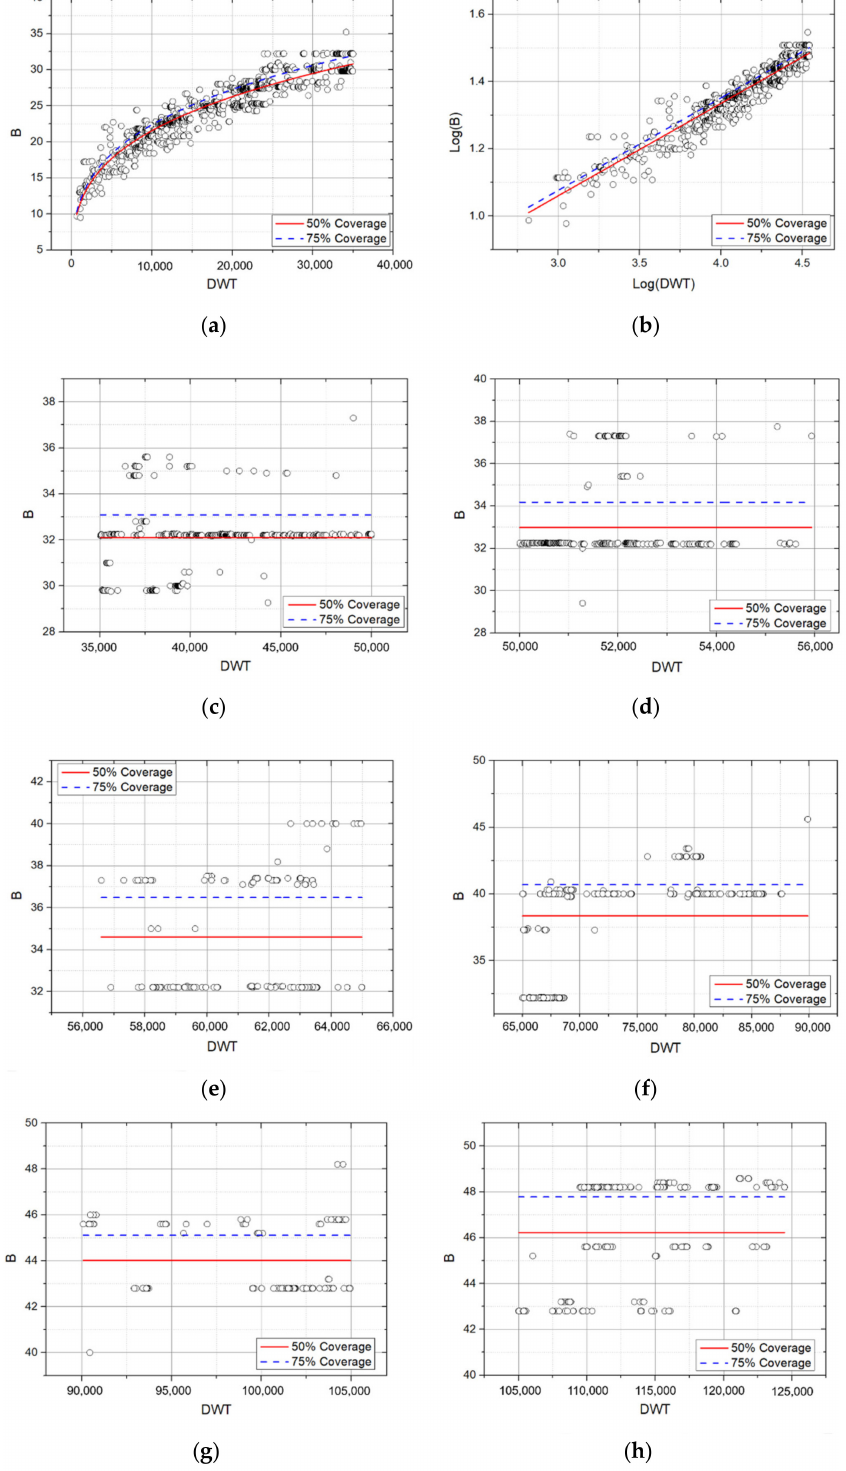
Figure 14. Results of regression analysis. ( a ) Deadweight tonnage (DWT)-breadth (B) graph of Cluster 1 (0–35,000 DWT); ( b ) Log(DWT)-Log(B) graph of Cluster 1 (0–35,000 DWT); ( c ) DWT-B graph of Cluster 1 (35,000–50,000 DWT); ( d ) DWT-B graph of Cluster 1 (50,000–55,000 DWT); ( e ) DWT-B graph of Cluster 2 (55,000–65,000 DWT); ( f ) DWT-B graph of Cluster 1 (65,000–90,000 DWT); ( g ) DWT-B graph of Cluster 2 (90,000–105,000 DWT); ( h ) DWT–B graph of Cluster 2 (105,000–105,000